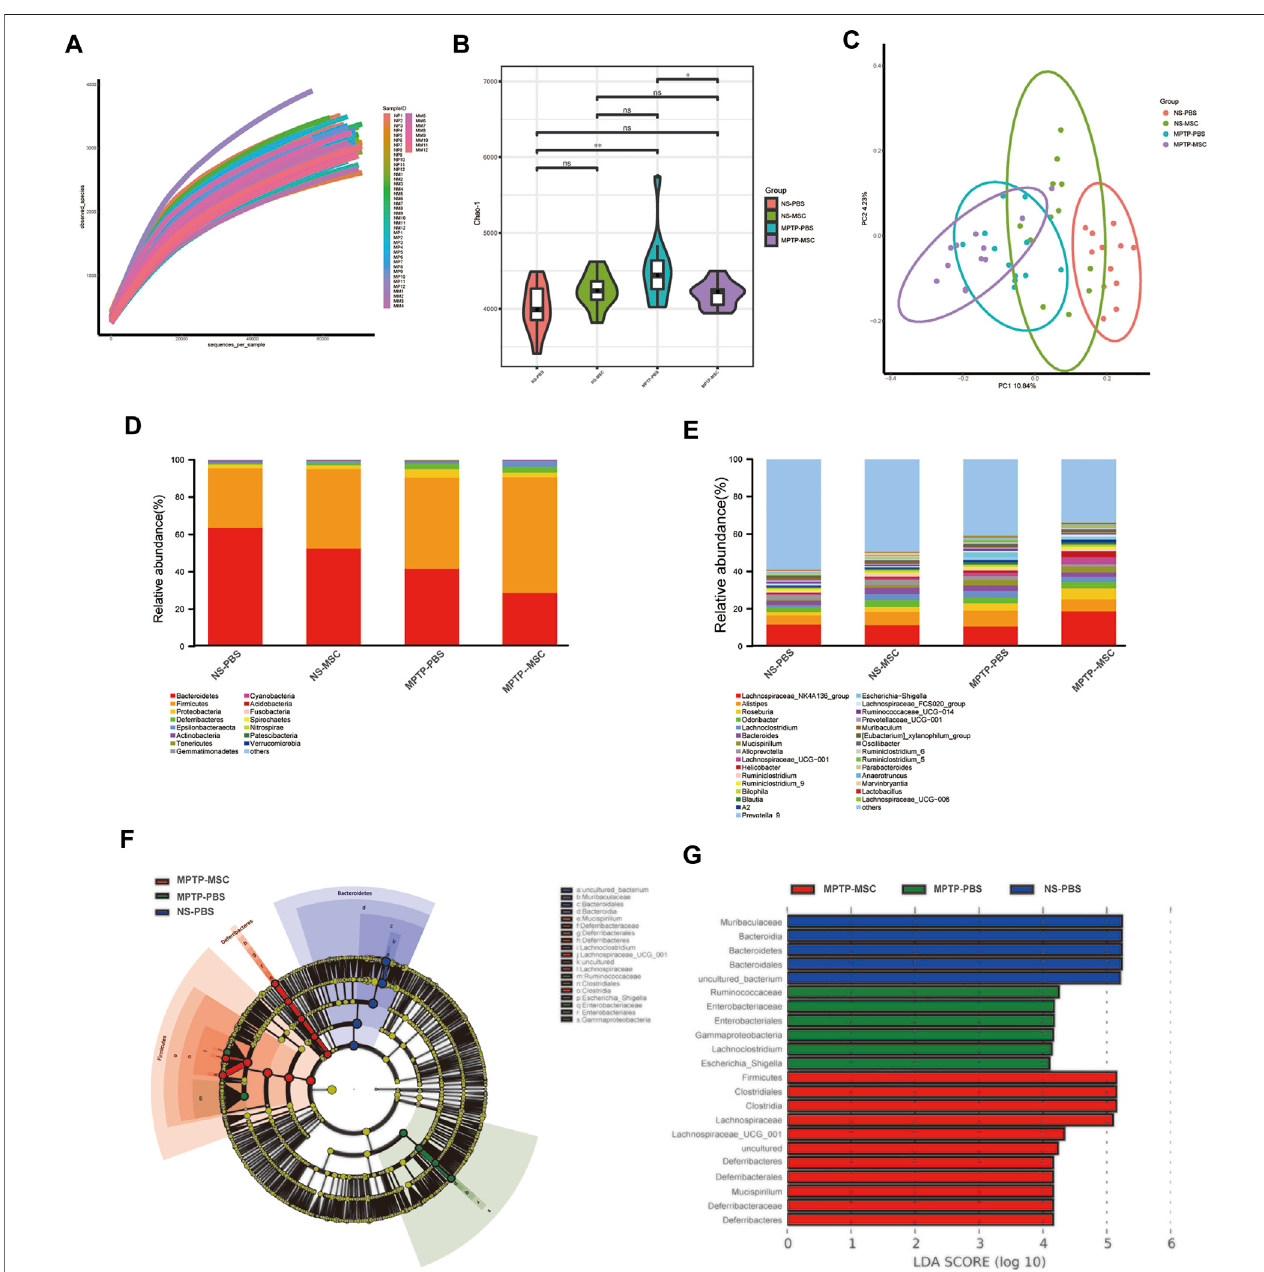
FIGURE4| UC-MSCsmodulatedthecompositionofgutmicrobiotainMPTP-inducedPDmice. (A) Rarefactioncurvesofsamples; (B) alphadiversitypresentedby Chao-1index; (C) PCoA analysisofsamples; (D) histogram based onrelative abundanceat phylum level; (E) averagerelativeabundanceofthemicrobialcommunityfor each group at the genus level. (F , G) Comparison of gut microbiota using LES among the NS-PBS, NS-MSC, MPTP-PBS, and MPTP-MSC groups at the OUT level. Cladogram (F) and histogram (G) of bacterial taxa that signi fi cantly differed among the three groups (LDA > 4.0 and p < 0.05). Blue, green, red, or shading in the cladogramdepictsbacterialtaxathatweresigni fi cantlyhigherintheNS-PBS,MPTP-PBS,orMPTP-MSCgroups, n (cid:1) 12pergroup.* p < 0.05,** p < 0.01comparedwith the MPTP-PBS group.